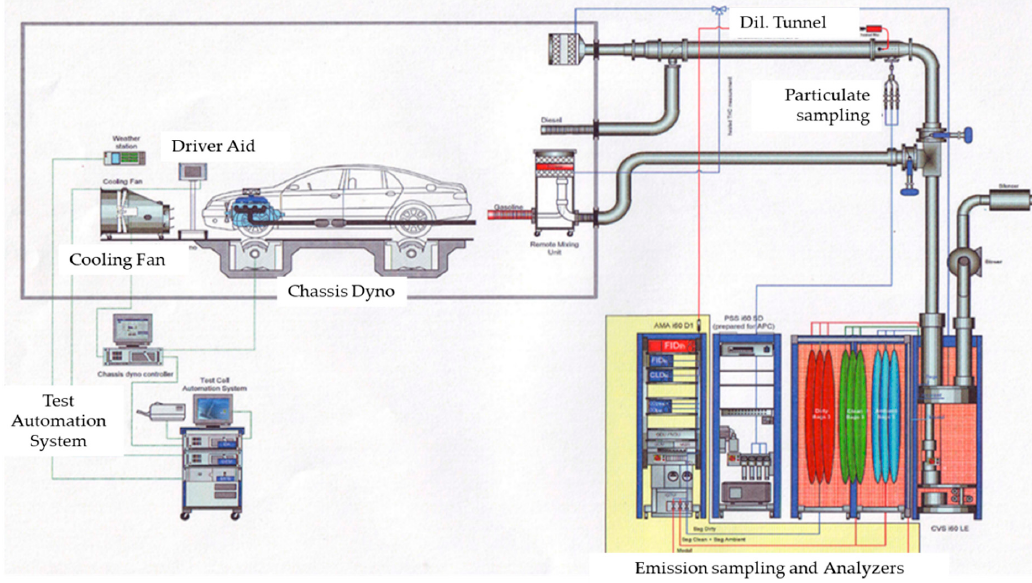
Figure 1. Schematic diagram of vehicle testing facility.